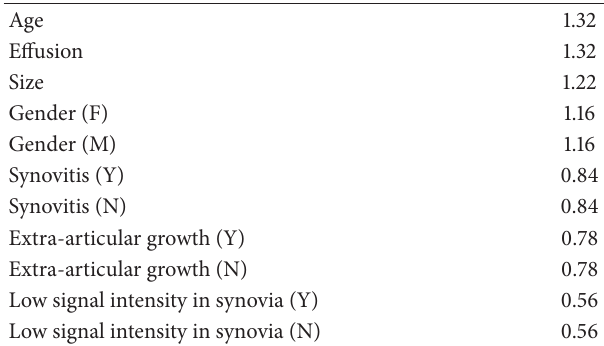
Figure 1: One-dimensional PLS-DA score plot showing the separa- tion of the two groups. The color of each dot represents the actual diagnosis of that case, where black corresponds to sarcoma and red tolocalizedPVNS.Greenandredhorizontallinescorrespondtotwo or three standard deviations (SD) of the 𝑡 1 vector. Table 3: Variable influence on projection (VIP) parameters for the variables in the